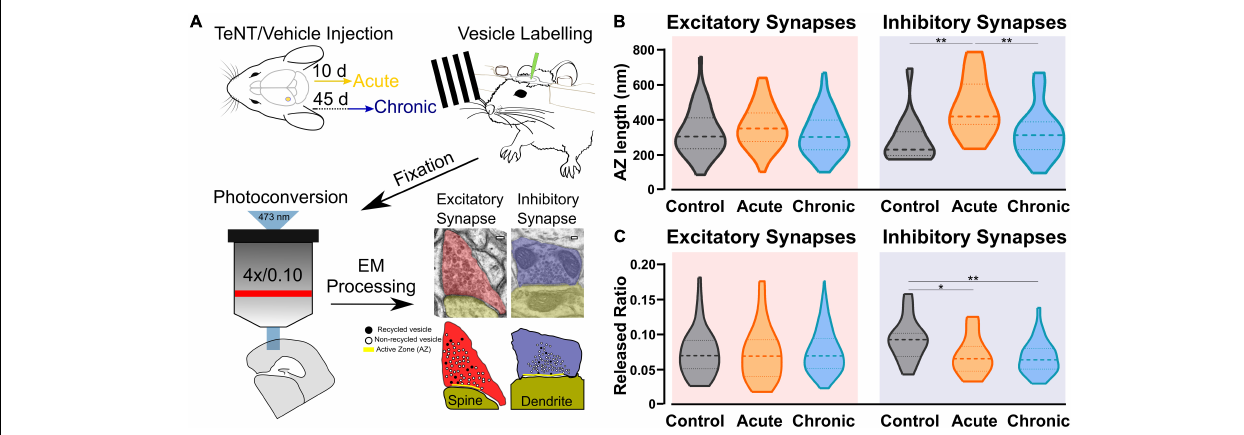
FIGURE 1 | Ultrastructural and functional changes at presynaptic terminals of TeNT-injected mice. (A) Diagrammatic representation of labeling protocol. Visual cortices from mice in Control, Acute, and Chronic groups were infused with FM1-43FX during visual stimulation. Brains were rapidly fixed and sliced to allow photoconversion of FM1-43FX signal before processing for electron microscopy. Individual presynaptic terminals were classified as excitatory (asymmetrical synapses, red) or inhibitory (symmetrical synapses, blue); size, position and numbers of active zone (AZ, yellow), non-released vesicles (open circles) and released vesicles (black circles) were analyzed (scale bars 100 nm). (B) Left: Active zone (AZ) length in Control (gray), Acute (orange), and Chronic (blue) epileptic mice at excitatory synapses; no differences between the groups (Kruskal-Wallis test, p = 0.10). Distribution, median and quartiles shown for each group; Control n =